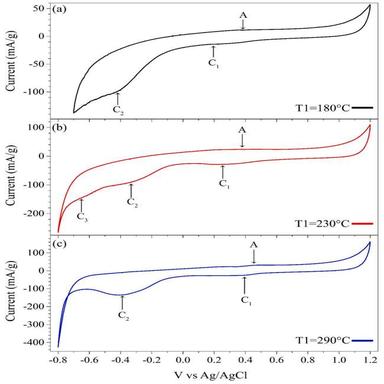
Cristina L. Rodríguez-Corvera et al. Voltammetry cycles for a scan rate of 10 mV/s. Results for samples synthesized at (a) T1 = 180 ◦C, (b) T1 = 230 ◦C, and (c) T1 = 290 ◦C. The observed peaks in–0.44 (a), − 0.33 (b), and − 0.40 (c) V are attributed to Fe3+. In (b), the observed peak around 0.65 V could be related to SH- group.